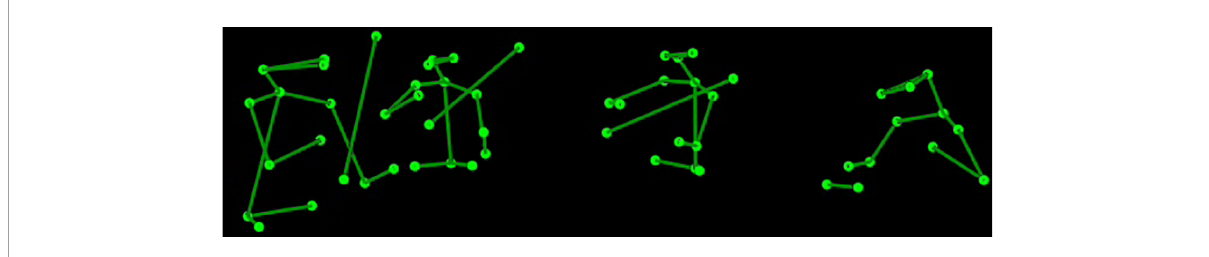
FIGURE1 The upper body stick figure display of the string quartet the ‘Quartetto di Cremona’.